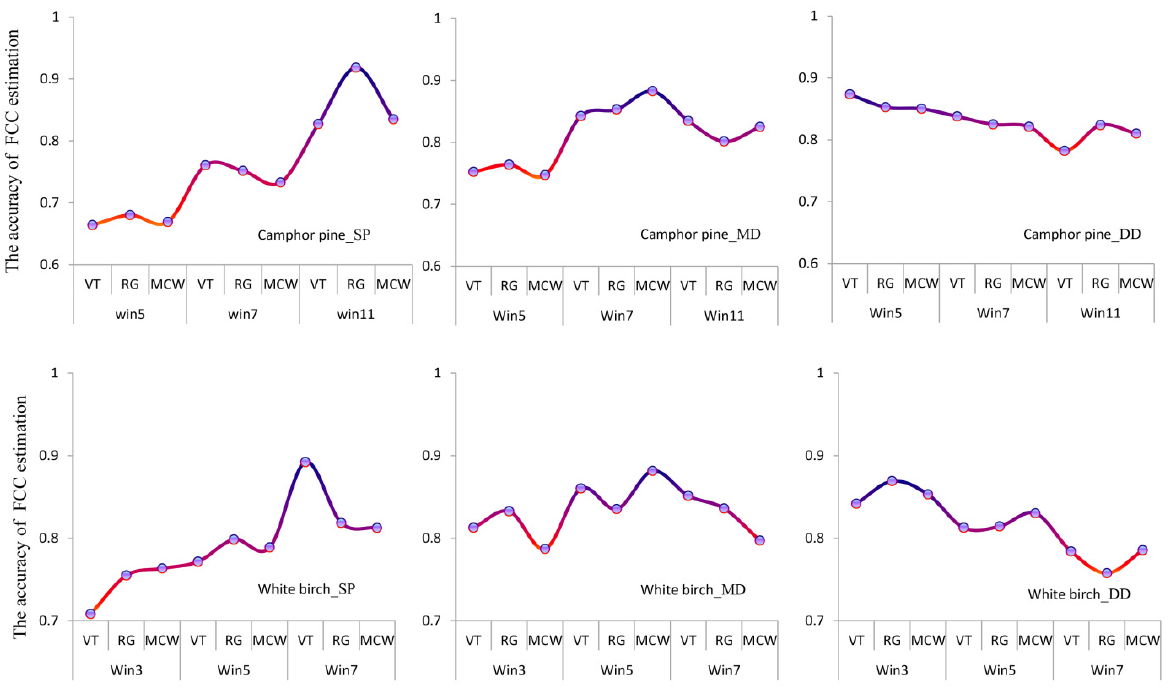
Figure 9. The accuracy comparison of FCC at various scenes using the method of integrating different window sizes to detect treetops and different algorithms to extract tree-crown boundaries. The three images above represent the case of camphor pine, while the three images below denote the case of white birch. Table 3. FCC-estimation accuracy of white birch forest. Win3_VT refers to adopting 3 × 3 window size to detect treetops and using the Voronoi tessellation algorithm to delineate tree-crown area. Our method refers to the FCC estimation of this study used, which combines the optimal results of treetop detection and tree-crown delineation.